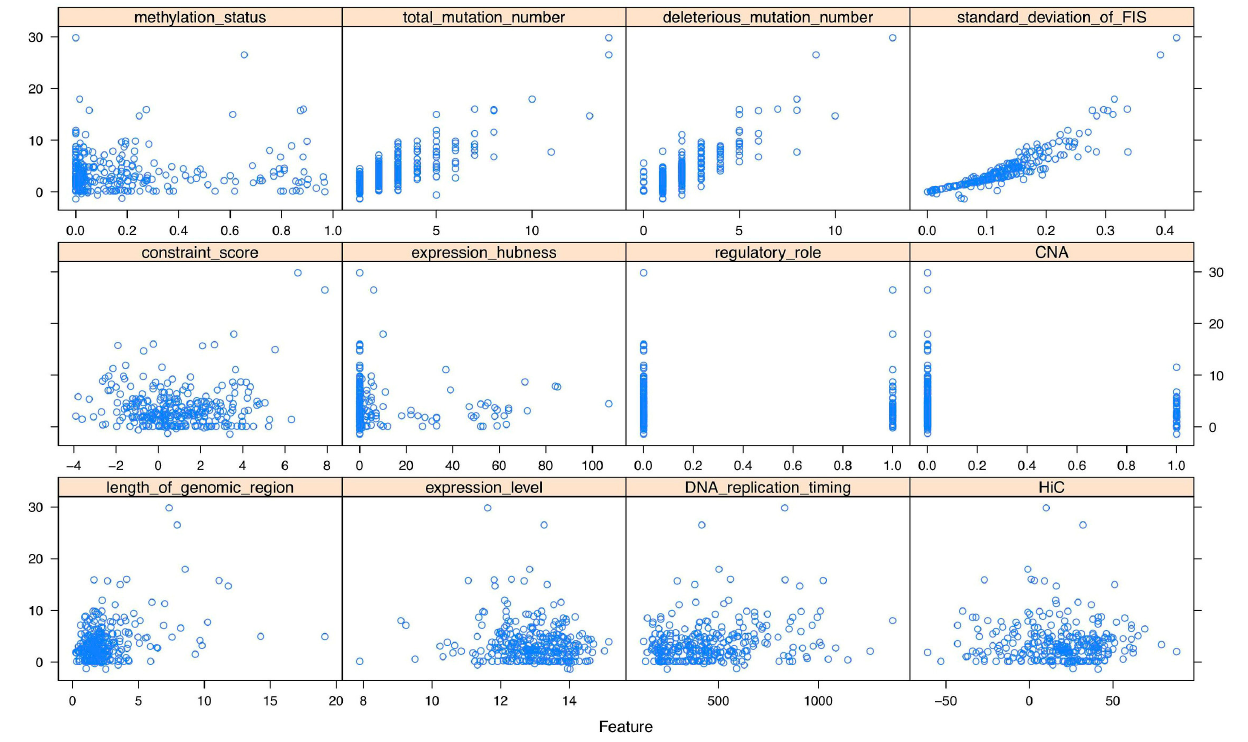
being the density function of the gamma distribution. G c is the number of genes in cluster c . Ŵ